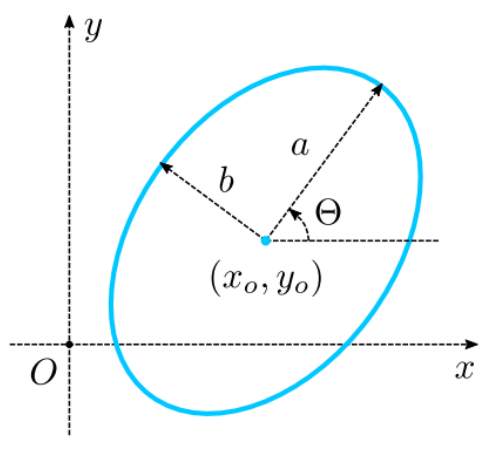
Figure 6. An ellipse parameterization approach provides an appropriate way to define bubbles. The ellipse model might also reduce the statistical error related to the unstable bubble